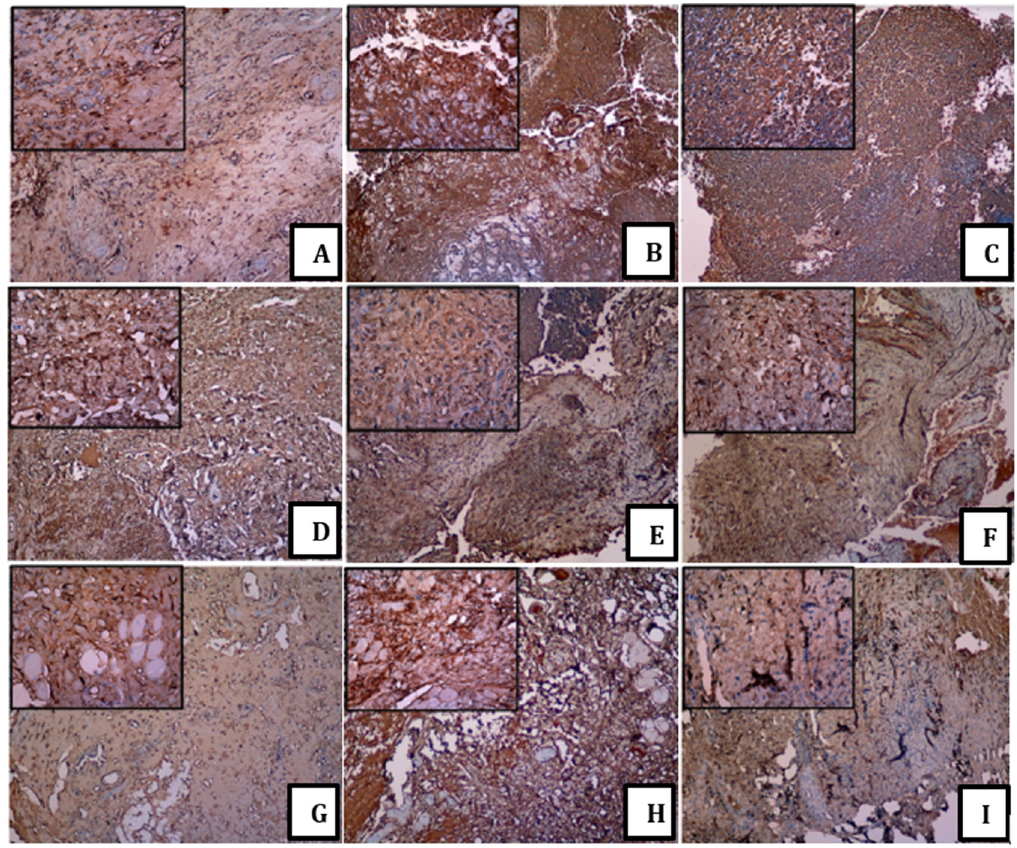
Figure 1. Immunohistochemistry of MMP-13 among a group. (A) control group day 3; (B) control group day 7; (C) control group day 14; (D) group 1 day 3; (E) group 1 day 7; (F) group 1 day 14; (G) group 2 day 3; (H) group 2 day 7;